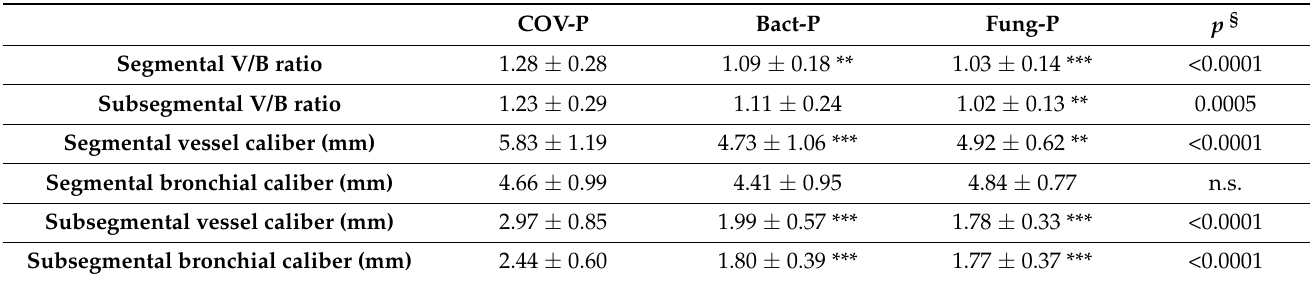
Table 2. Calibers of the segmental and subsegmental branches of the pulmonary arteries and their corresponding bronchial branches, measured in the areas of lung opacification, and the V/B ratios calculated.